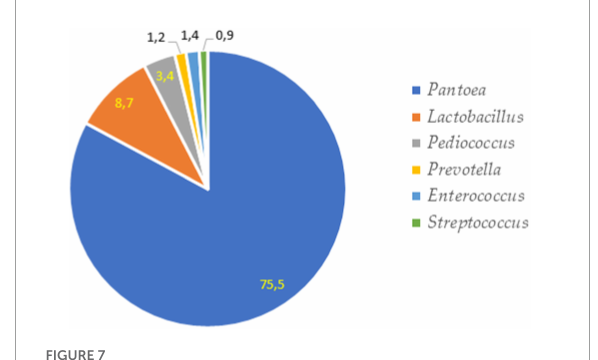
FIGURE7 The most prevalent bacterial genera in non-fermented wheat cereal wholemeal (WCW) (DS8472-5)